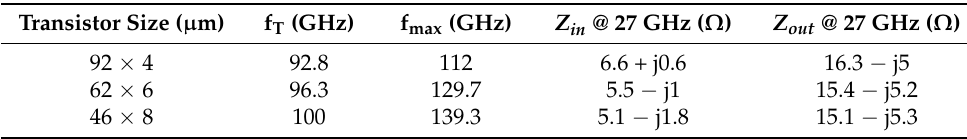
Table 1. Simulated f T , f max , and the terminal impedances of three unit cells with different fingers but similar TGWs (around 370 µ m) at the nominal bias conditions of V ds = 12 V and V gs = − 1 V, where the maximum device DC and AC transconductance appear.